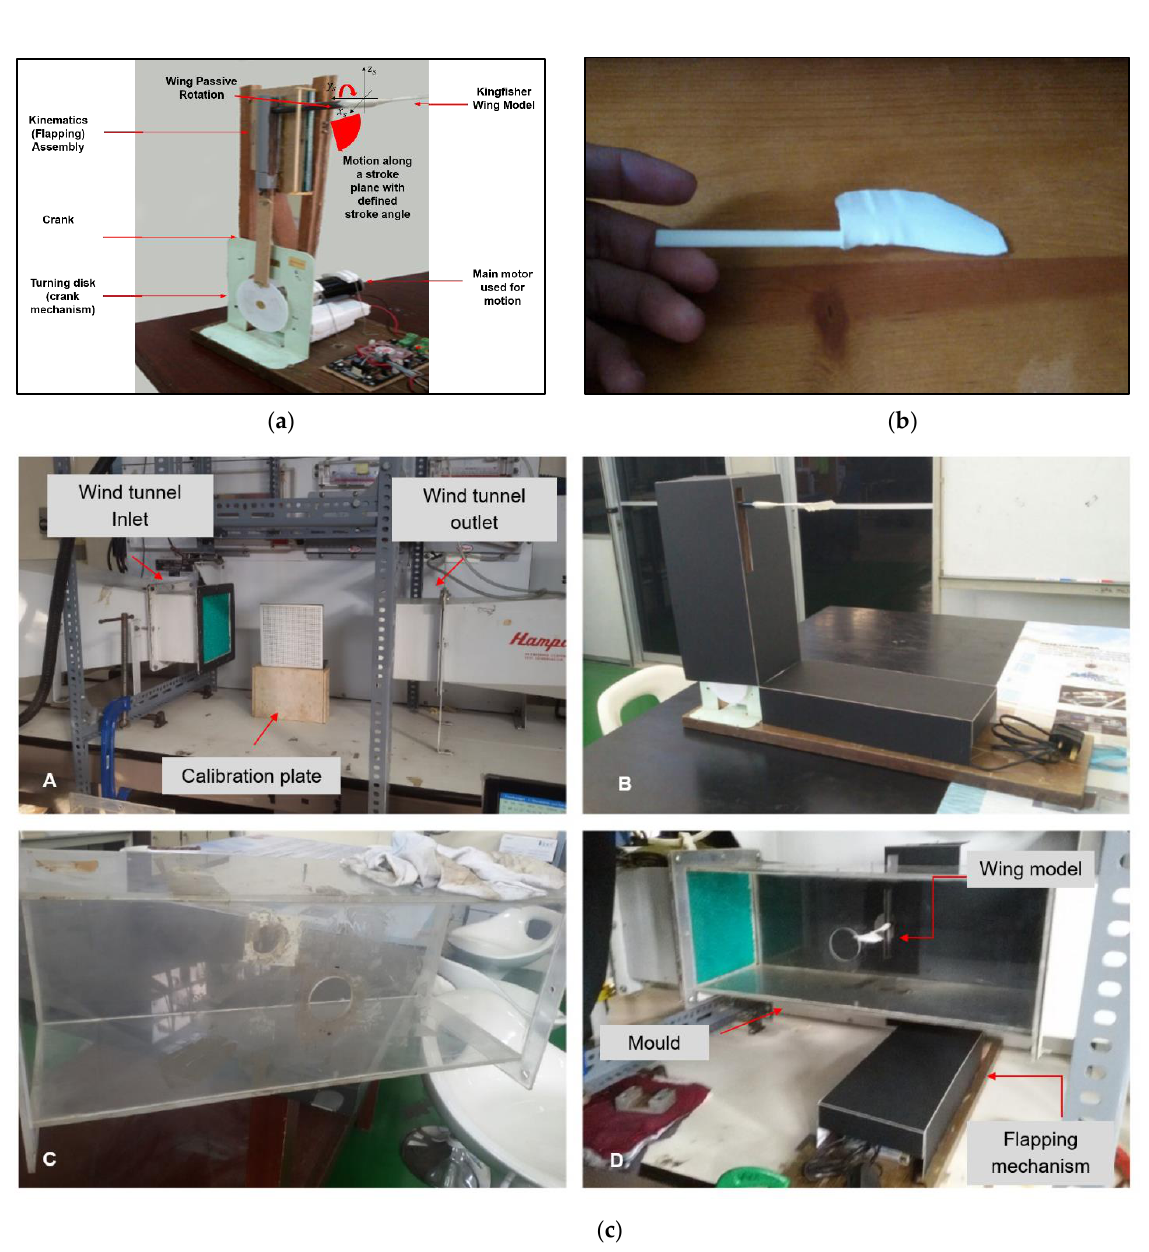
Figure 7. ( a ) Flapping Wing experimental test rig; ( b ) 3-D printed wing model product for experimental run; ( c ) details of the experimental test rig (flapping mechanism test setup); experimental setup consists of ( A ) PIV measurement area calibration; ( B ) completed flapping mechanism with mounted wing model, ( C ) test rig, and ( D ) completed PIV experiment assembly.